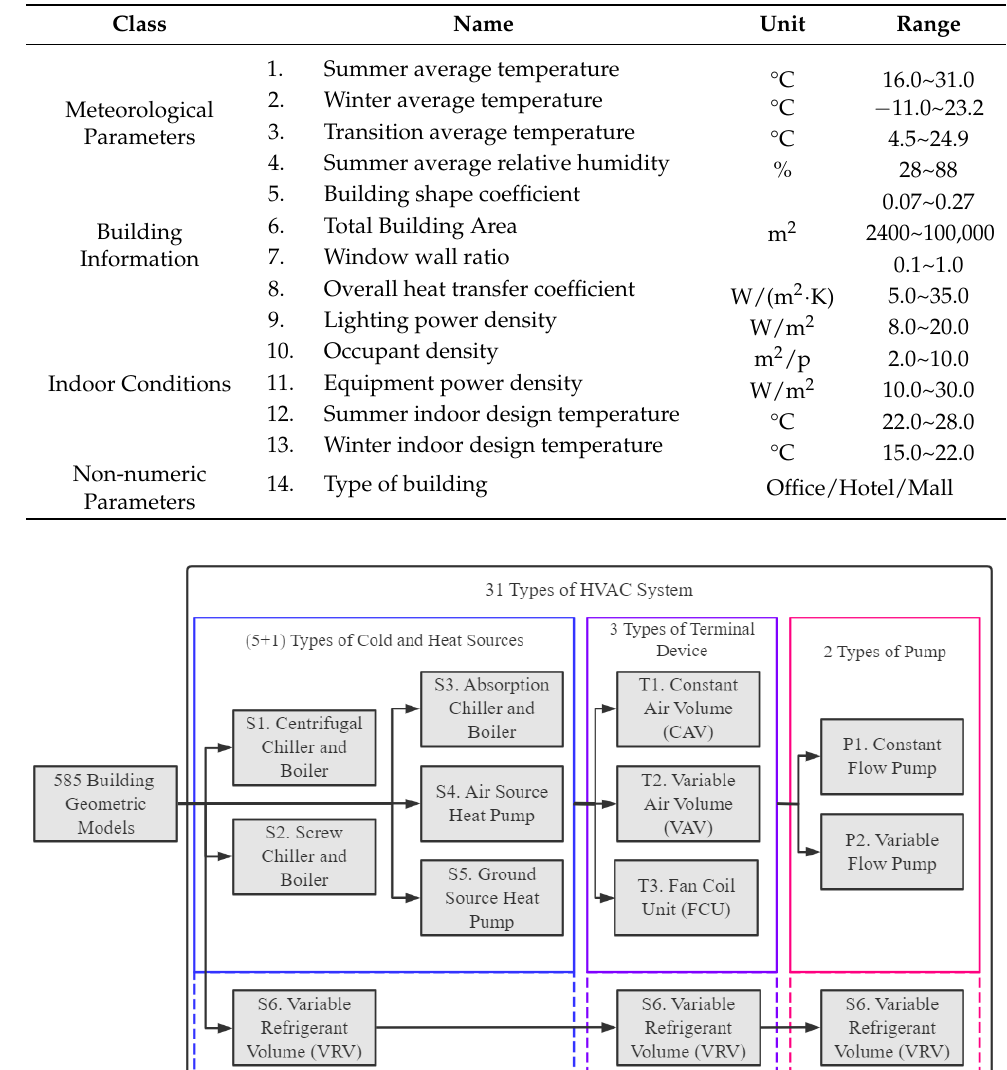
Table A1. Model parameters list of the building models in database.